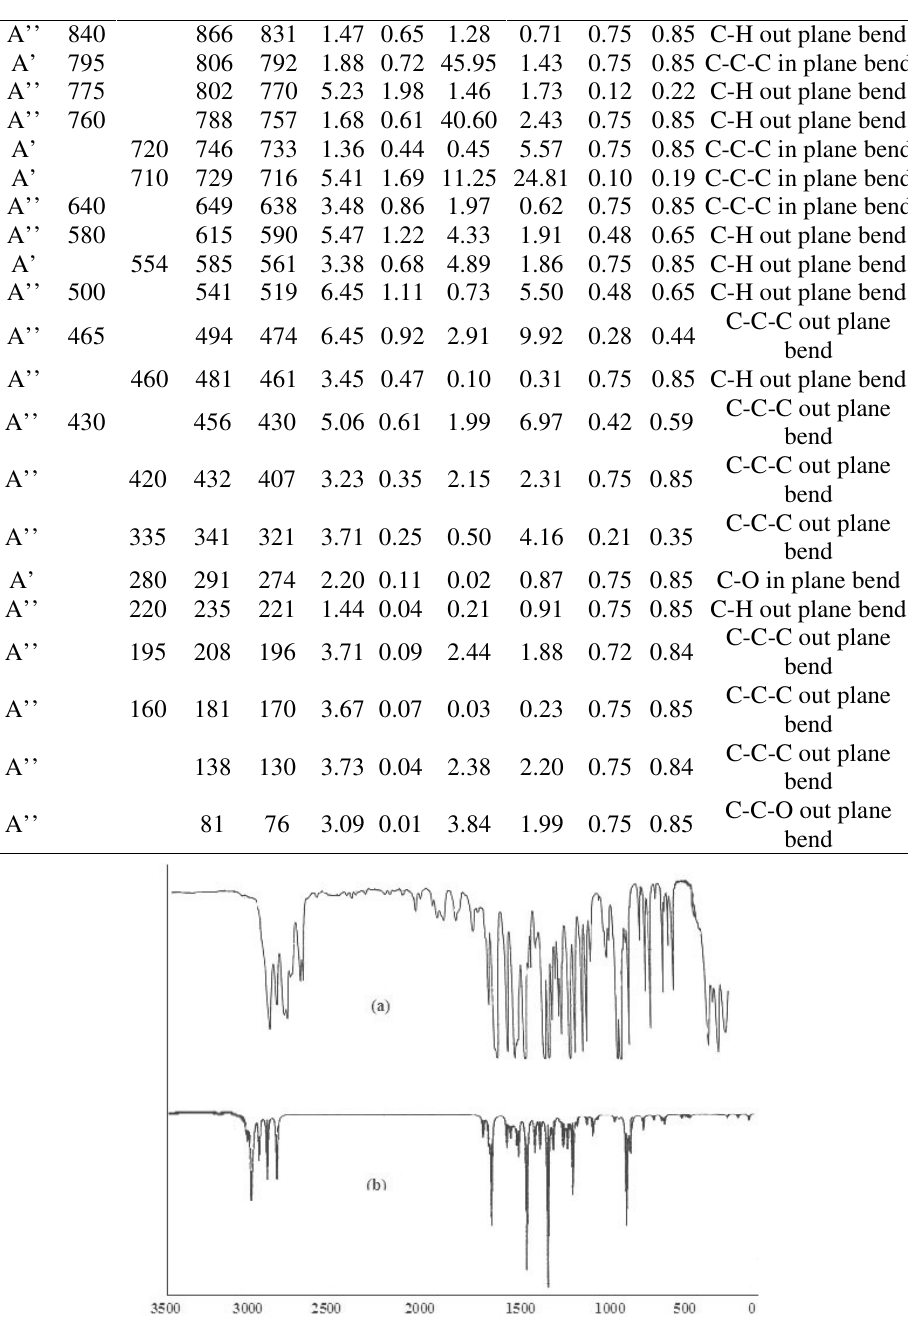
Figure 2. Comparison of observed and calculated FI-Raman 1-methoxynaphthalene. (a) Observed (b) calculated with B3LYP/6-31G